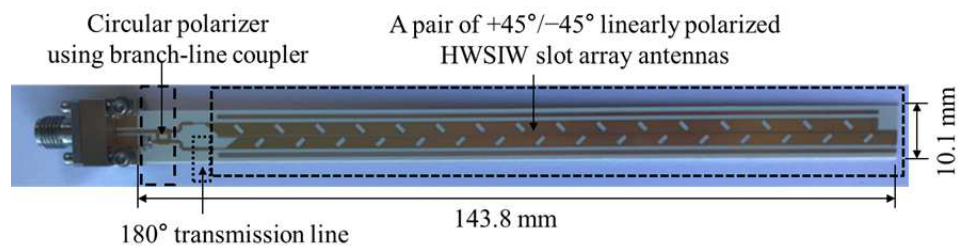
Figure 9. Picture of the fabricated HMSIW RHCP slot array.